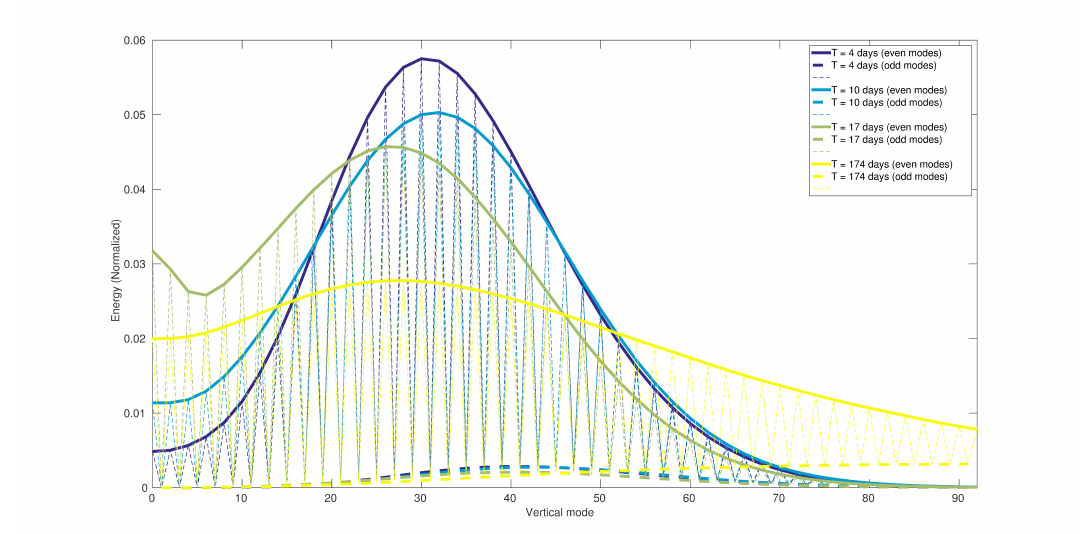
Figure 8. Energy distribution on the vertical modes of the optimal perturbations for time intervals τ = 4, 10, 17 and 174 days (Energy of each vertical mode normalized by the total perturbation energy). As an effect of the vertical symmetry of the vortex lens, even modes have much more energy than odd modes. Whereas the time interval does not have a clear effect on the most energetic vertical modes (centre of the spectral peak), it clearly affects the width of the spectral peak. The longer the time interval, the wider the energy